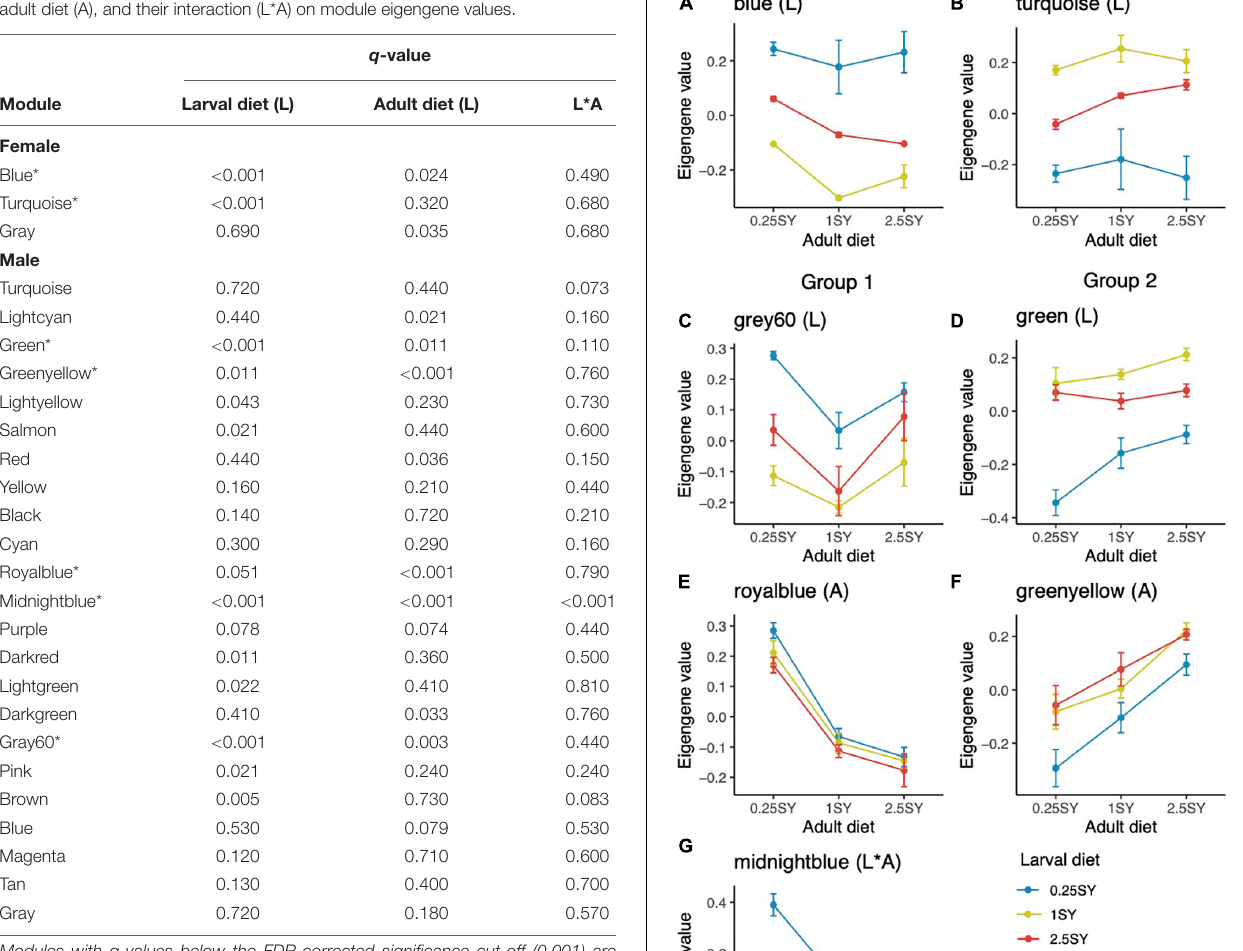
two were affected by larval diet (gray60, green), two by adult diet (royal blue, green yellow), and one by their interaction (midnight blue). The modules could be broadly divided into